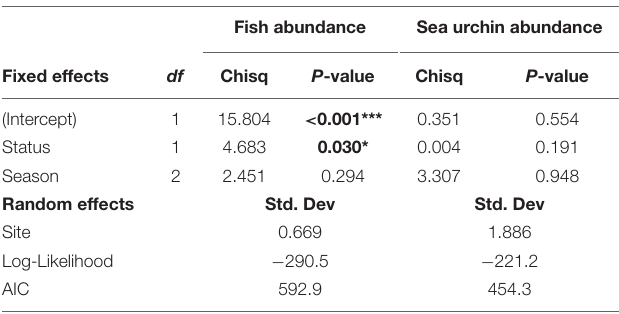
TABLE 2 | Influence of conservation Status (fixed covariate with two levels: healthy vs. degraded) and Season (fixed covariate with three levels: autumn, winter, and spring) on the abundance of seaweed-eating fish and sea